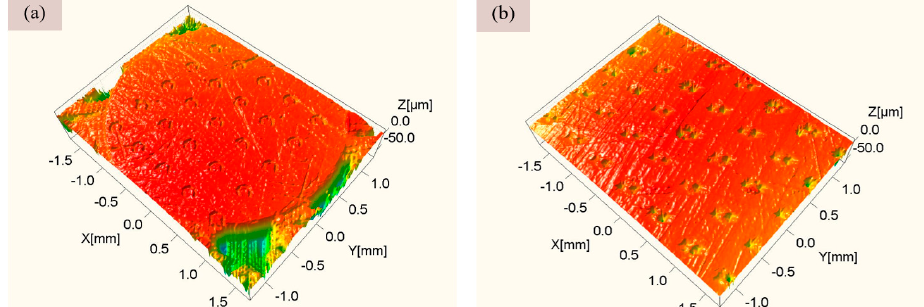
(GCr15) pin and ethylene propylene diene monomer (EPDM) rubber: ( a ) GCr15 pin surface with a Figure 3. Three-dimensional topography of surface textures of the carbon chromium bearing steel